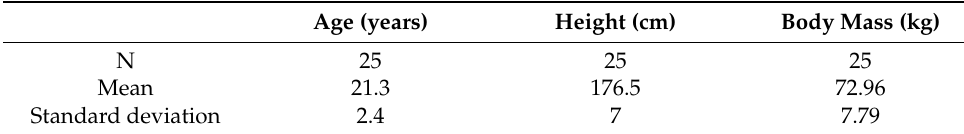
Table 1. Characteristics of the participants in the